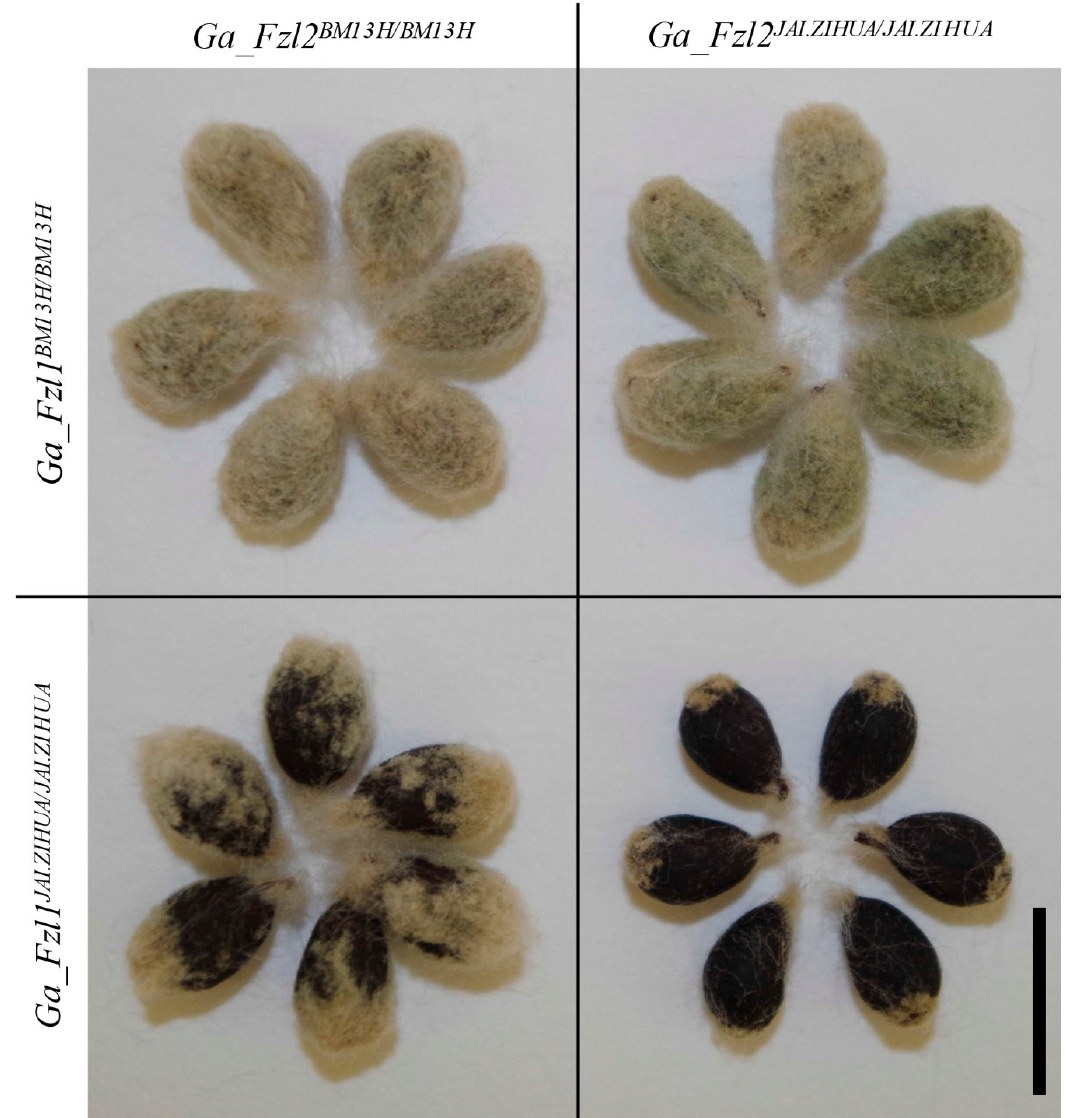
Figure 4. Phenotype segregation analysis of seeds with different combinations of Ga_Fzl1 and Ga_Fzl2 alleles (scale bar = 1 cm). Row names indicate the genotype of Ga_Fzl1 , and column names indicate the genotype of Ga_Fzl2 .